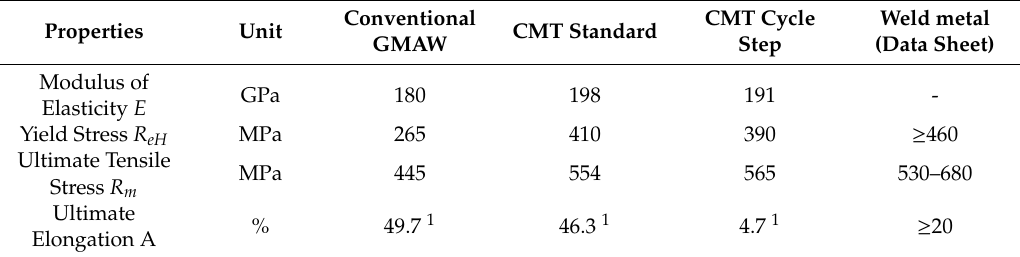
Table 3. Mechanical properties of the three bars and the welding wire.